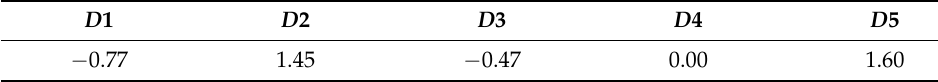
Table 2. The input fracture parameters for the J–C model [34].